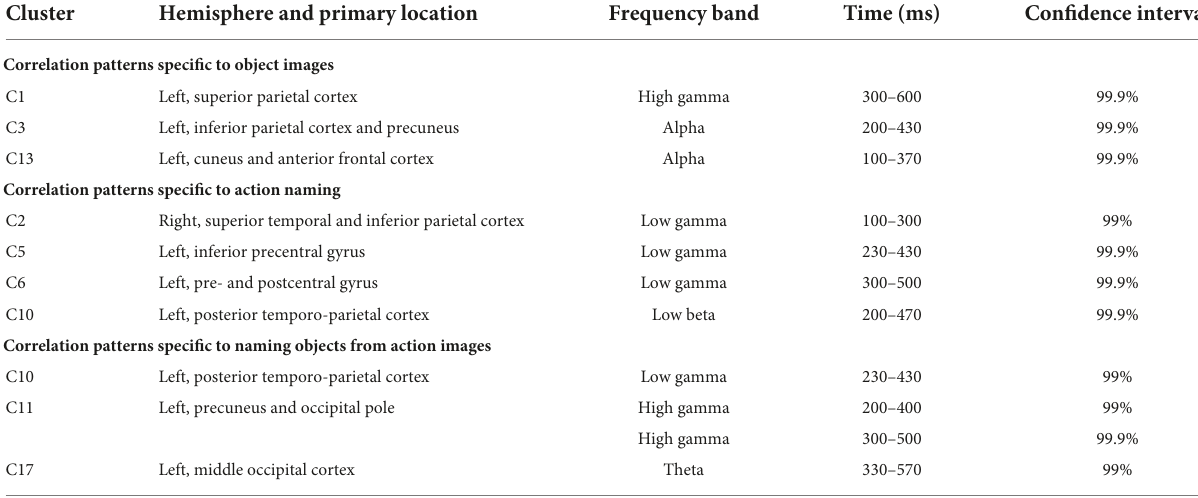
TABLE 1 Significant effects detected with the given clusters, frequency bands, and significant time intervals.